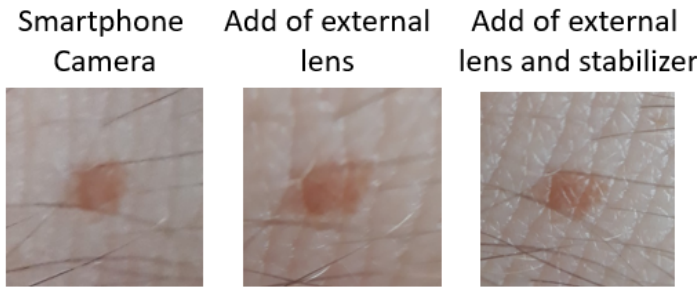
Figure 8. Images from a smartphone camera, smartphone camera with lens, and smartphone camera with lens and the handmade stabilizer.